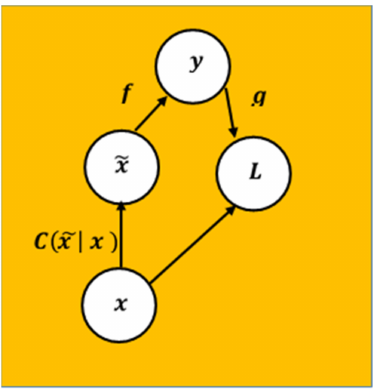
Figure 6. The DAE neural network’s computational